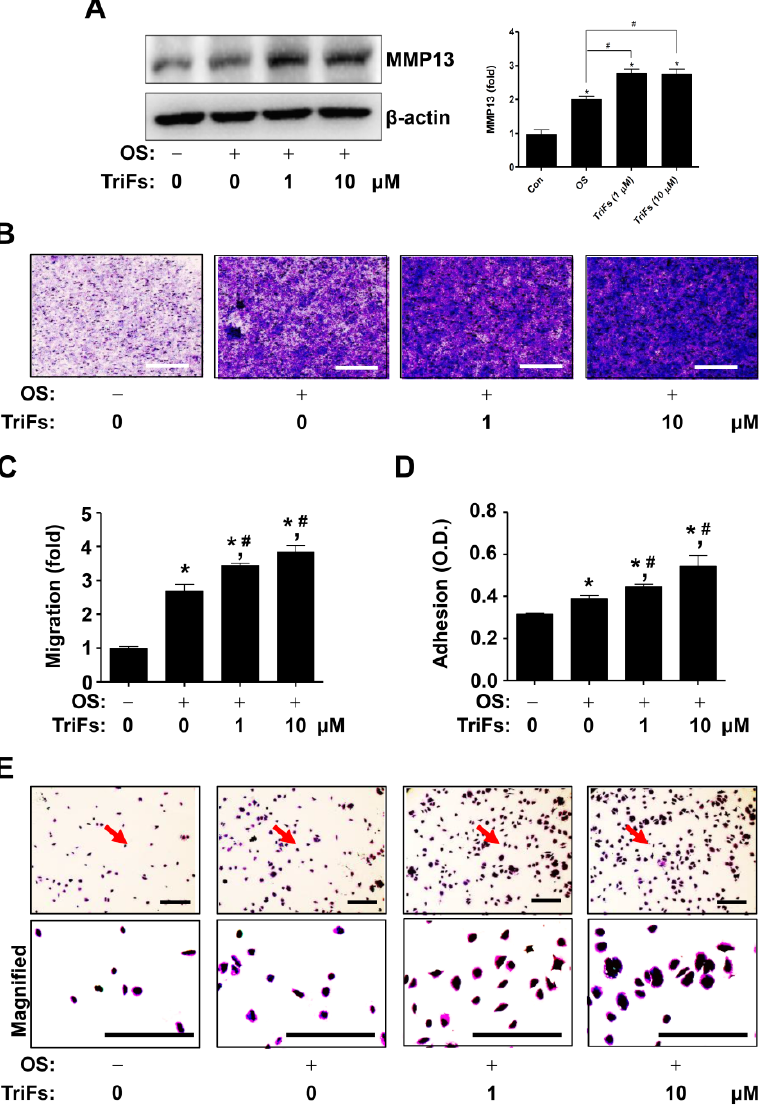
Figure 5. Osteogenic effects of trifloroside (TriFs) on MMP13 production, cell migration, and cell adhesion. ( A ) Western blotting was used to determine MMP13 levels. The values (fold) were normalized to β -actin and were displayed as a bar graph. ( B , C ) A Boyden chamber was used to determine the migration of TriFs-treated osteoblasts; a light microscope was used to visualize cell migration ( B ) and the values (fold) are displayed as a bar graph ( C ). ( D , E ) An adhesion assay was used to determine the adhesion of TriFs-treated osteoblasts and the numeric values (O.D.) are displayed as a bar graph ( D ). A light microscope was used to visualize cell adhesion, and the red arrows point to the magnified areas ( E ). *, p < 0.05 indicates significant differences when compared to the control. #, p < 0.05 indicates significant differences when compared to OS. Data are presented as mean ± standard error of the mean (S.E.M.). Data shown are from three independent trials. Scale bar: 50 µ